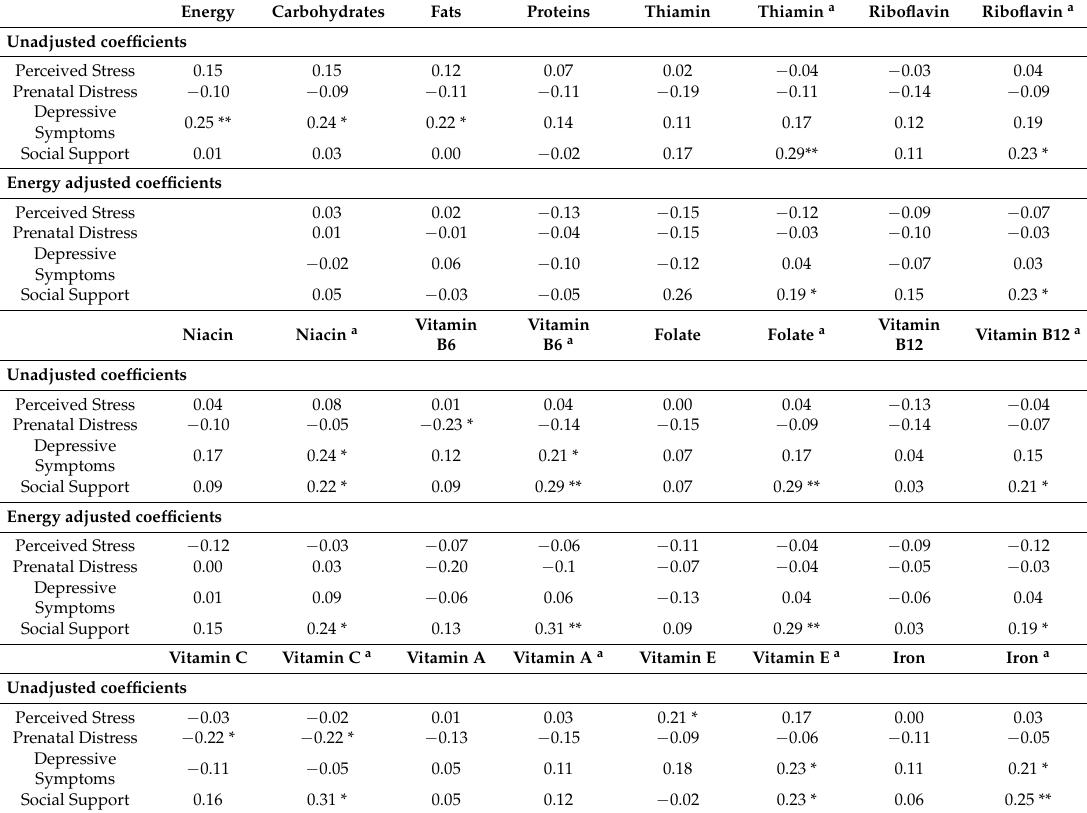
Table 3. Association between nutritional intake, stress, depressive symptoms, and social support in 108 pregnant Latina